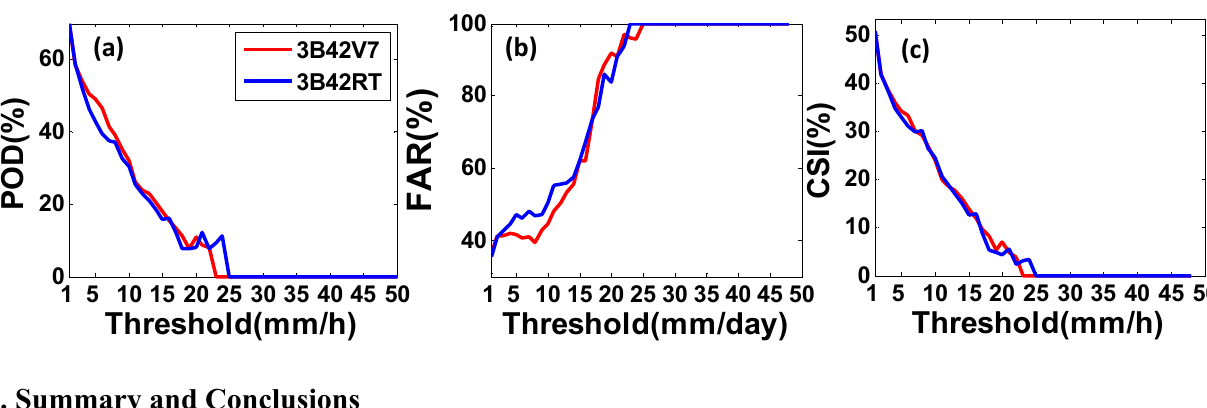
Figure 6. Contingency statistics for ( a ) probability of detection (POD); ( b ) false alarm ratio (FAR); and ( c ) critical success index (CSI) with bin interval of 1